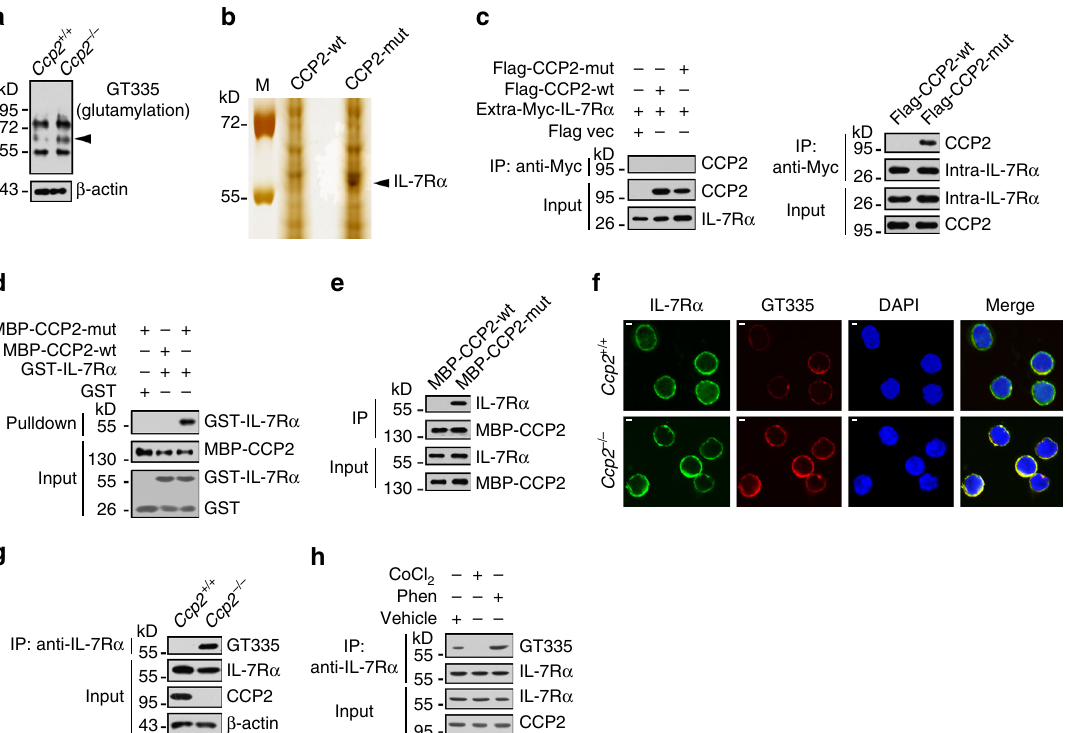
Fig. 3 IL-7R α is a substrate of CCP2 in CHILPs. a BM cells from WT and Ccp2 − / − mice were lysed. Protein glutamylation was examined with GT335 antibody by western blotting. Arrowhead denotes the differential band. b Recombinant CCP2-wt and enzymatic inactive CCP2 mutant (CCP2-mut) were immobilized with Af fi -gel10 resin and assessed by addition of Ccp2 − / − BM lysates. The eluted fractions were resolved by SDS-PAGE, followed by silver staining. M: molecular weight marker. A differential band of ~60 kD appeared in CCP2-mut lane and was cut for mass spectrometry. The peptide sequences and coverage of IL-7R α analyzed by LC-LTQ MS/MS are shown in the bottom graph. c Myc-tagged extracellular (amino acid: 21 – 239) or intracellular (amino acid: 265 – 459) segment of IL-7R α and Flag-tagged CCP2-wt or CCP2-mut were co-transfected in 293 T cells for 36 h. Cell lysates were incubated with anti-Myc antibody for immunoprecipitation assay. IP immunoprecipitation. d GST-tagged intracellular segment of IL-7R α (GST-IL-7R α ) was incubated with MBP-tagged CCP2-wt or CCP2-mut at 4 °C for 4 h, followed by incubation with GST beads. e CCP2-wt and CCP2-mut were incubated with BM lysates for pulldown assay. f CHILPs were incubated with GT335 and anti-IL-7R α antibodies for immuno fl uorescence staining. IL-7R α , green ; GT335, red ; nucleus, blue . Scale bar , 2 μ m. g BM lysates from WT or Ccp2 − / − mice were immunoprecipitated with anti-IL-7R α antibody, followed by immunoblotting. h WT BM cells were treated with CoCl 2 or Phen. Cells were lysed and IL-7R α glutamylation was assessed. Data represent four independent As expected, CoCl 2 treatment suppressed the generation of ILC3s, whereas Phen treatment increased the formation of ILC3s (Fig. 2c, d). Finally, Ccp2 − / − CHILPs did not undergo apparent apoptosis (Fig. 2e, f). Altogether, polyglutamylation is required for the differentiation of ILC3s from their progenitor CHILPs.